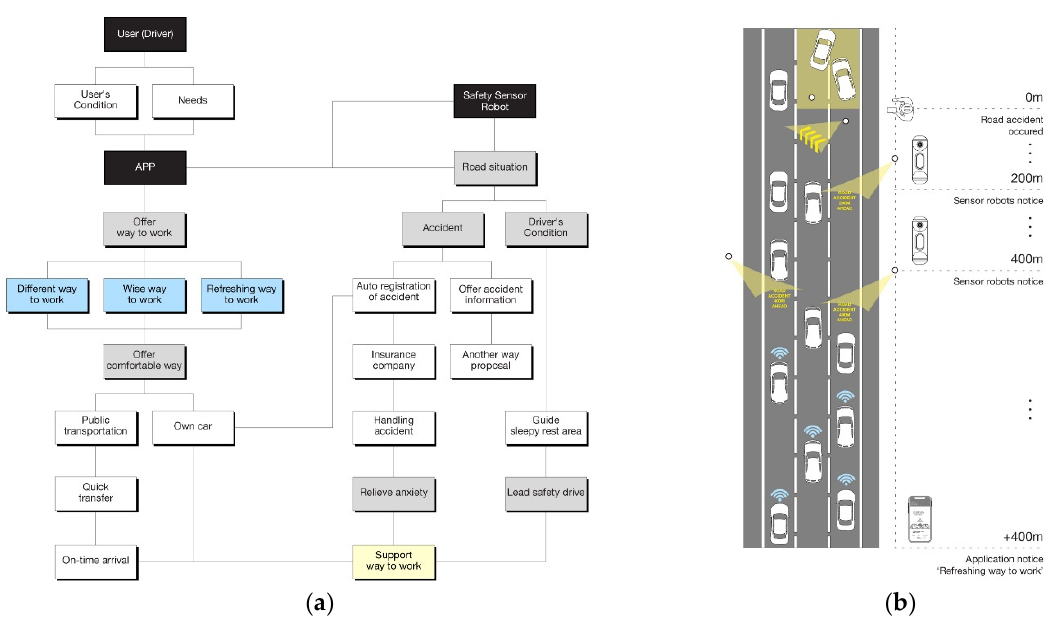
Figure 14. ( a ) Information architecture that aims for a ( b ) comfortable commute experience. Data from [3,6].